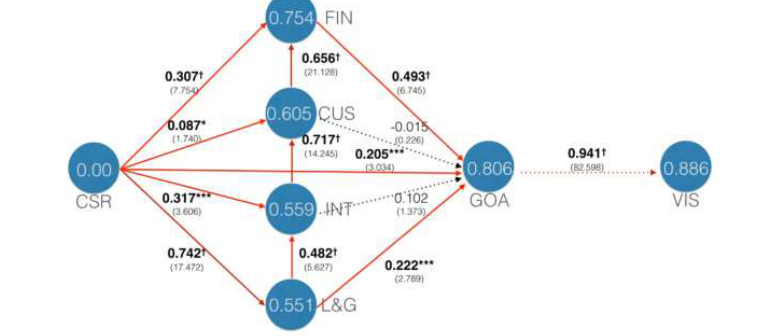
Fig. 10. 𝑅 (cid:2870) and path coefficient for